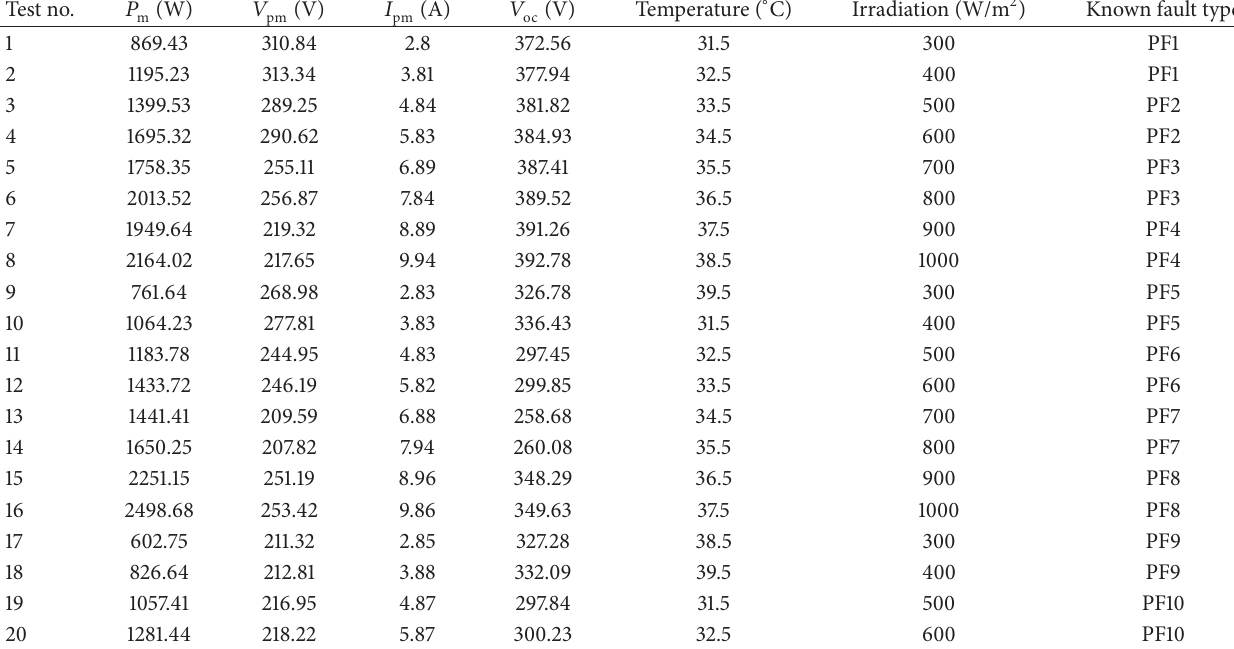
Table 4: Test data under 300–1000 W/m 2 irradiation and PV module surface temperatures between 31 and 40 ∘ C. Test no.